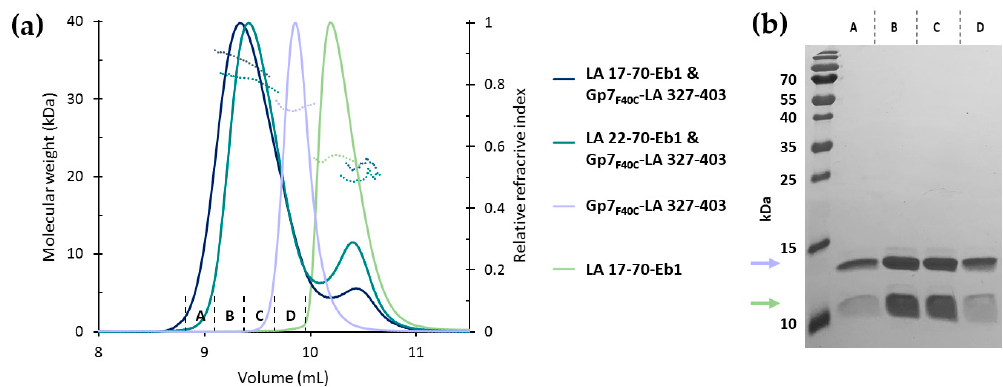
Figure 6. ( a ) SEC-MALS analysis of the LA 17-70-Eb1 / Gp7 F40C -LA 327-403 complex (1:1 ratio), LA 22-70-Eb1 and Gp7 F40C -LA 327-403 complex (1:1 ratio), the Gp7 F40C -LA 327-403 construct and the LA 17-70-Eb1 construct. The LA 17-70-Eb1 / Gp7 F40C -LA 327-403 complex and both individual constructs were run in 150 mM NaCl, 10 mM Hepes (pH 7.5) buffer. The second complex was run in 150 mM NaCl, 10 mM TEA (pH 7) buffer. Solid lines show the normalized refractive index profiles. Dashed lines show the MALS-based molecular weight values across the peaks. ( b ) SDS-PAGE of chromatographic fractions corresponding to the main peak of the LA 17-70-Eb1 / Gp7 F40C -LA 327-403 complex in (a). The blue and green arrows indicate Gp7 F40C- LA 327-403 and LA 17-70-Eb1, respectively.